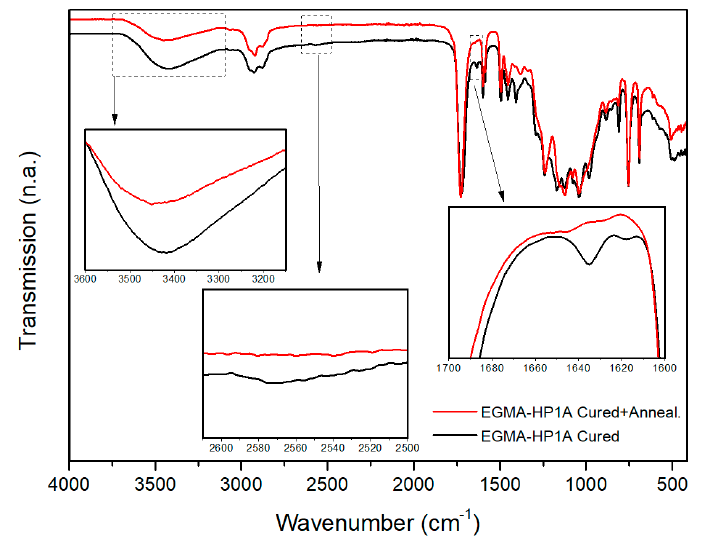
Figure 47. ATR-FTIR spectra of thiol-acrylate 3D printed samples prior to and after thermal annealing at 180 °C for 4 h. Inset plots present zoomed images of the -OH (3600–3200 cm − 1 ), -SH (2600–2500 cm − 1 ), and C=C-H (1700–1600 cm − 1 ) absorption bands before and after thermal annealing. Reproduced with permission from [101]. Copyright © 2022